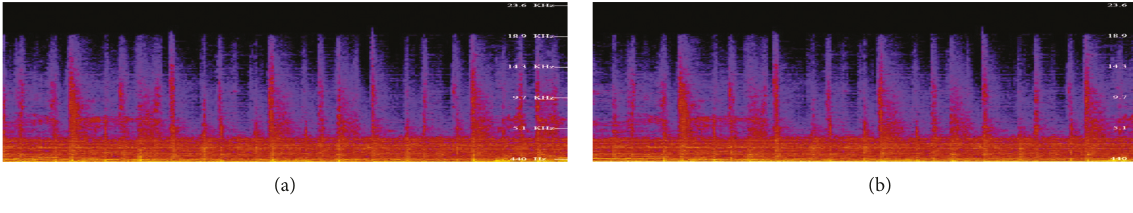
Figure 4: Frequency spectrum of cover audio (a) and stego audio (b).